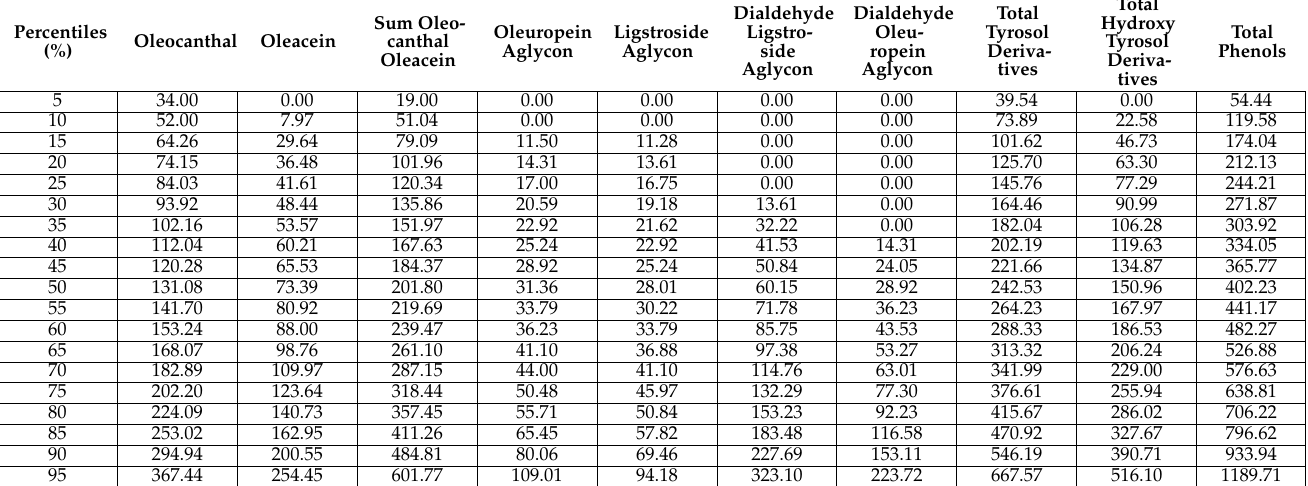
Table 5. Percentiles (5%) of phenolic content of the examined samples ( n =